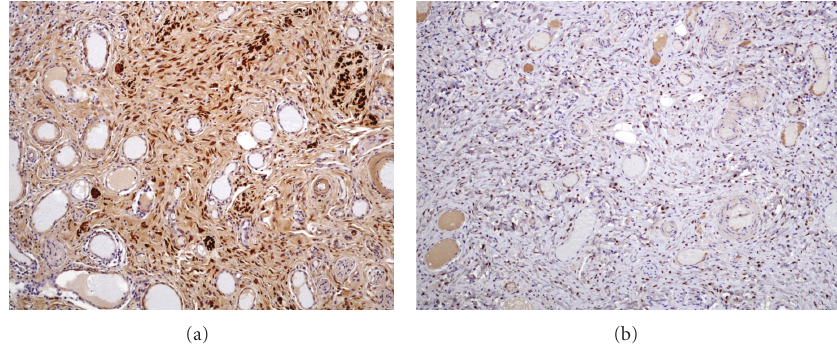
Figure 3: (a) Photomicrograph (immunohistochemical staining for desmin, original magnification × 10) showing desmin positivity for mesenchymal proliferation. (b) Photomicrograph (immunohistochemical staining for estrogen receptors, original magnification × 10) showing positivity of stromal elements for estrogen receptors.